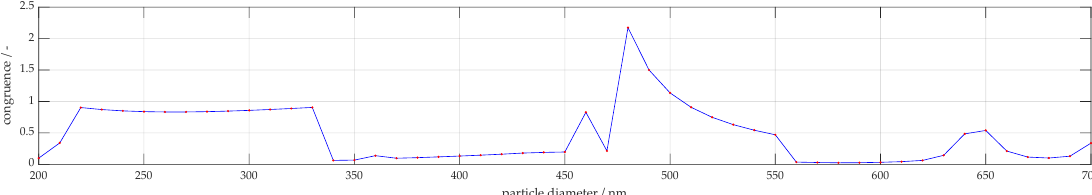
Figure 4. Example of a congruence diagram of the 500 nm scattering pattern compared to the simulation.